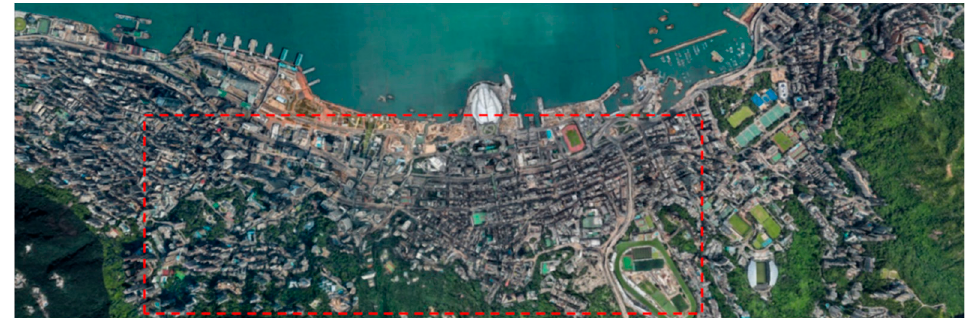
Figure 10. Tiled image of the study area (red dotted square) in Hong Kong’s Central District.